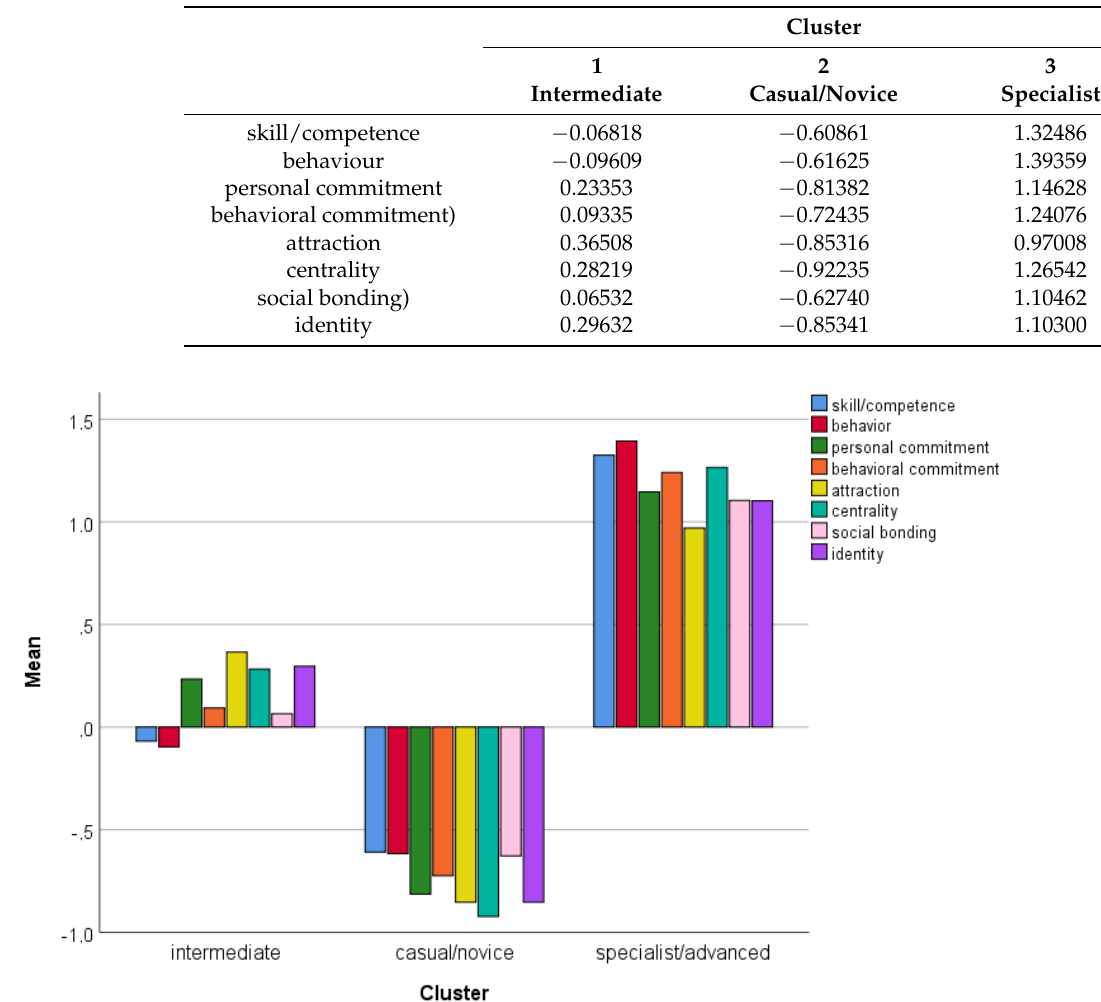
Figure 2. Distribution of the three clusters (intermediate, casual/novice and specialist/advanced) among gender. ** denote significant differences ( p < 0.01). 6. Discussion This study presents results from a large cross-sectional sample of birdwatchers reach- ing different levels of recreation specialization. Concurrent with other studies, our sample was slightly older (47 years) than the mean in Germany (44.2 years; [37]). However, mean age was much lower than in other comparable studies, e.g., in [22] where 75% were over 45 years, or in [16] with an age range between 48 and 54 years. One reason for this might be that birdwatching as a leisure activity may have attracted younger people during the last decade(s). However, there are no data supporting this claim. Also, the birdwatchers in this study showed a high degree of education, with nearly 10% holding a PhD degree. This has been found in some other studies as well [22]. Thus, birdwatching in German